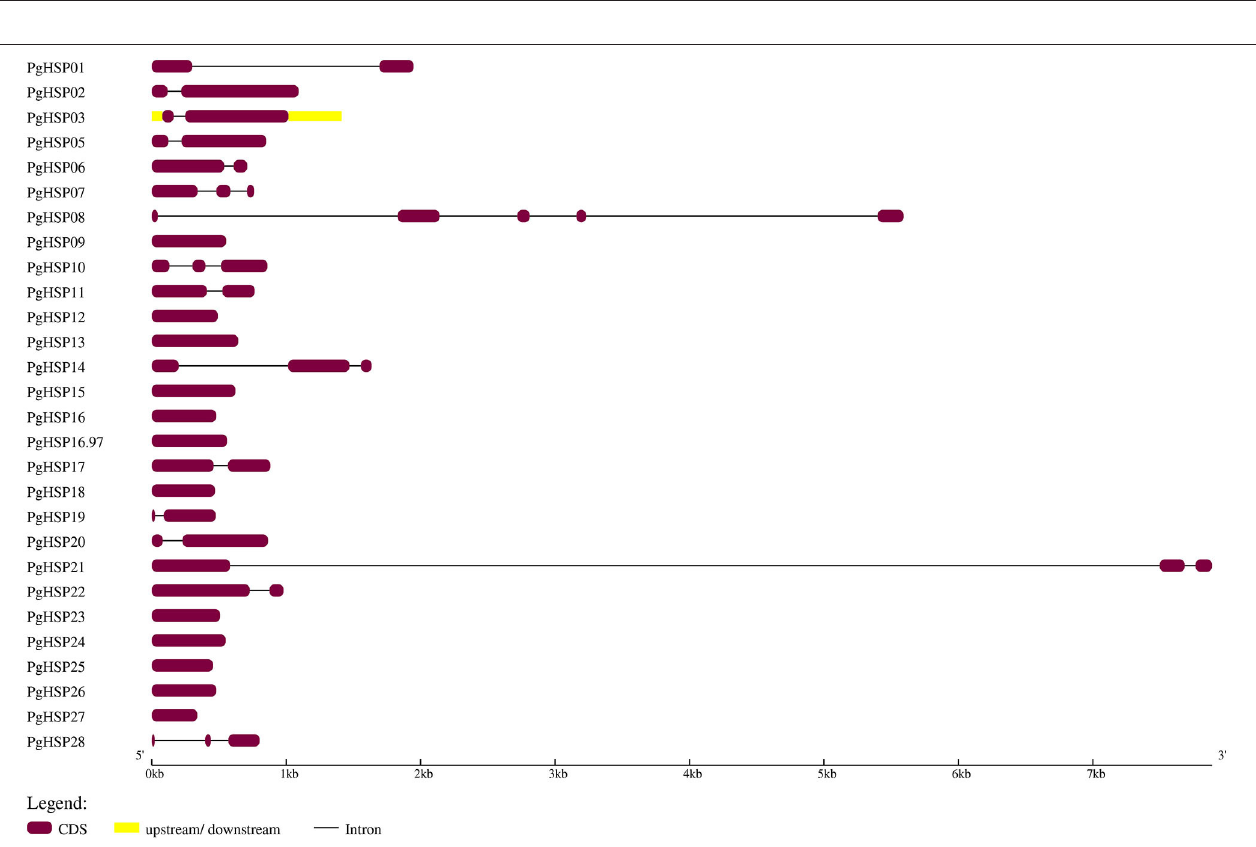
FIGURE 7 | Structural elucidation of the identified 28 PgHSP20 genes. The diagram represents the exon and intron present in genomic DNA, in which exons were represented by violet boxes (https://figshare.com/s/504eb0133d9e684232e7).